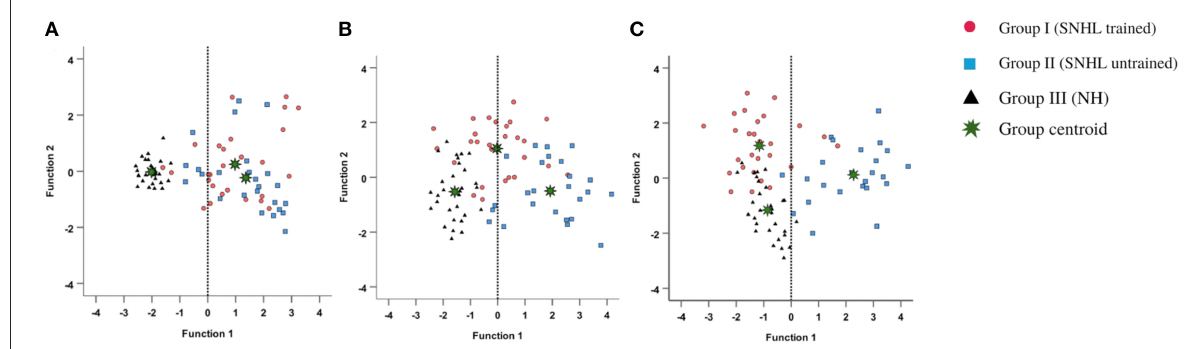
FIGURE7 Grouping participants based on canonical discriminant scores derived for behavioral measures of spatial acuity at (A) pre-, (B) mid-, and (C) post-training evaluation phases. The red circles, blue squares, and black triangles correspond to discriminant scores of group I (SNHI-trained), group II (SNHI-untrained), and group III (NH) participants, respectively. The categorization of the groups is evident on the significant function, i.e., DF1. Function 2 is merely used for plotting the abscissa values, and group classification is not elaborately discussed as this function was not